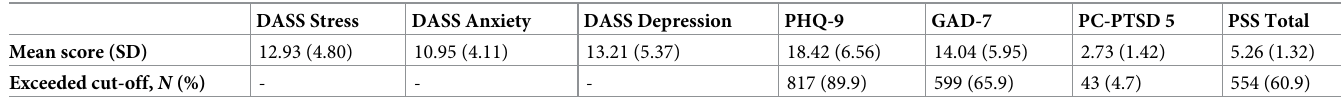
Table 4. Mental health of the surveyed student sample (N =